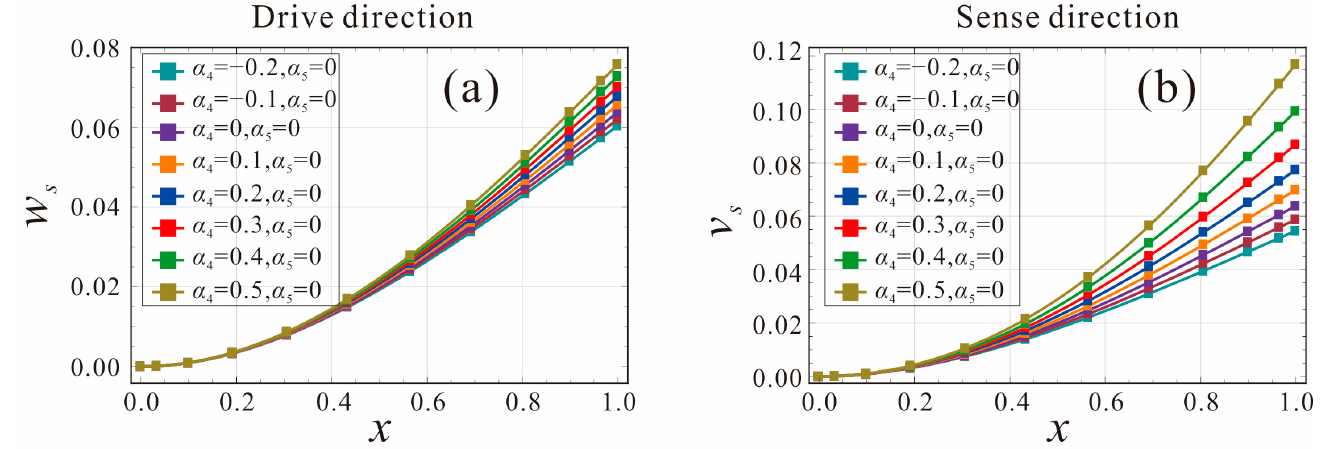
Figure 4. Effect of shape factors α 4 and α 5 on the static deflection of the micro-gyroscope: ( a ) drive direction; ( b ) sense direction.